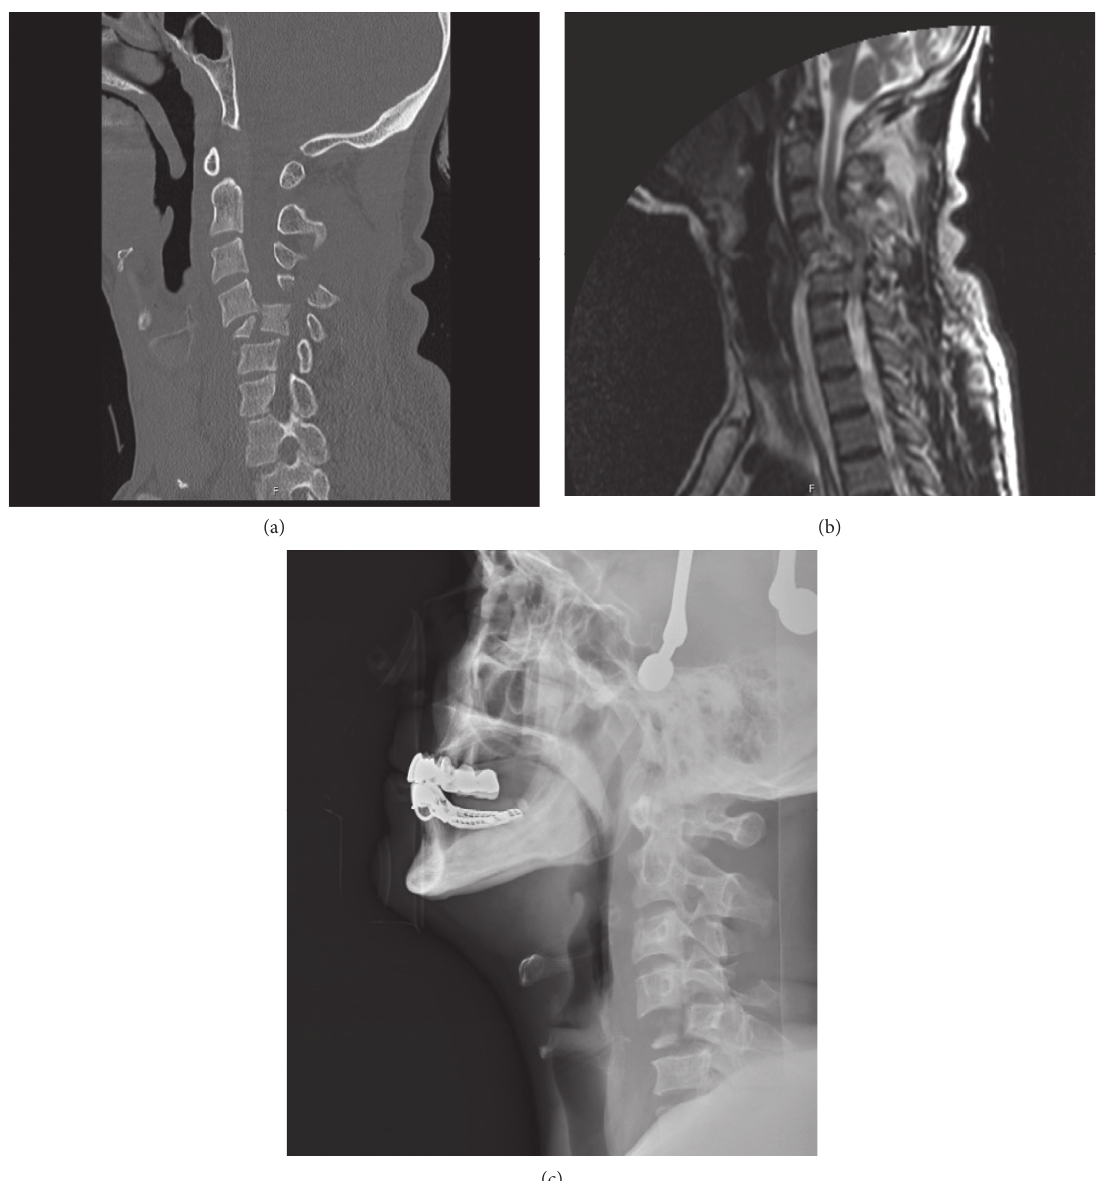
Figure 1: Computerized tomography (a), magnetic resonance imaging (b), and plain radiograph views (c) of cervical spine injury after dive into shallow